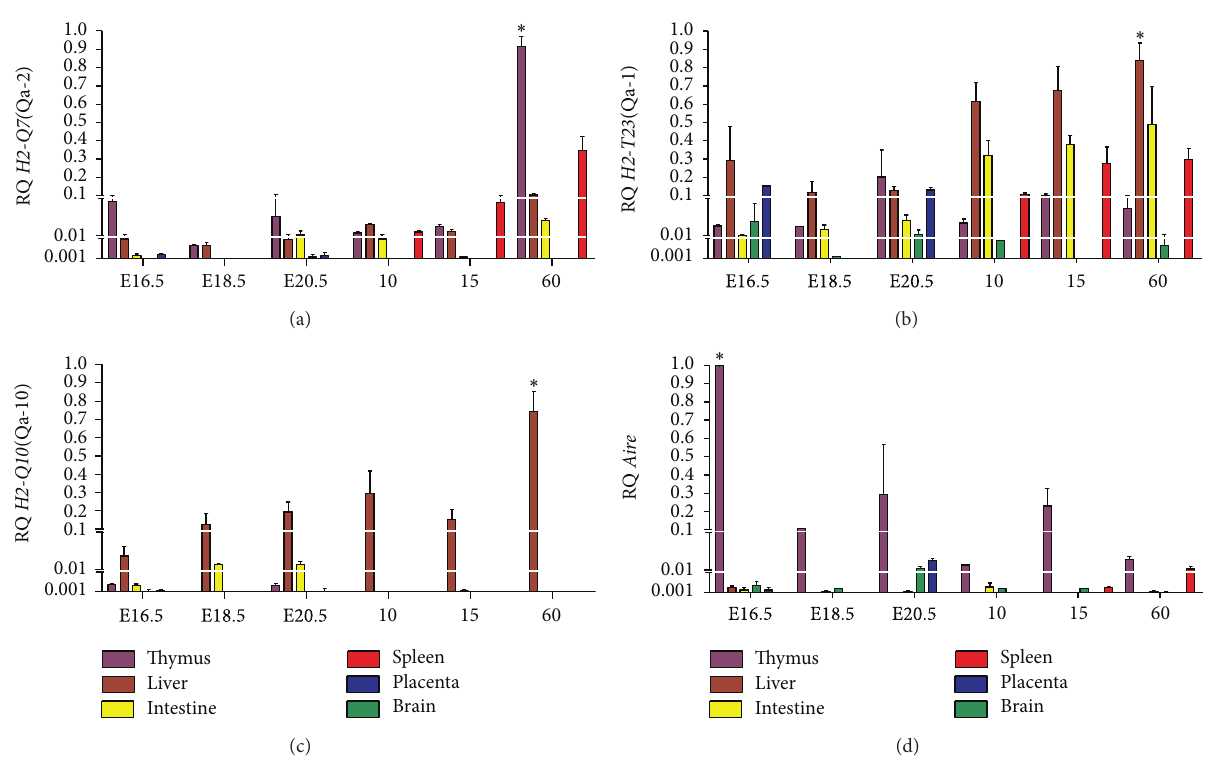
Figure 1: Analysis of MHC class Ib and Aire transcripts in different tissues of C57BL/6 mice. Relative quantification (RQ) of messenger RNA for (a) H2-Q7 (Qa-2), (b) H2-T23 (Qa-1), (c) H2-Q10 (Qa-10), and (d) Aire is representative of the mean values of 2 −ΔΔ Ct . Tissue samples were obtained in triplicate from different animals for each age analyzed. Each experiment was independently performed at least three times. Data were analyzed statistically by two-way ANOVA followed by the Bonferroni multiple comparison test. Values close to the level of significance are marked with ( ∗